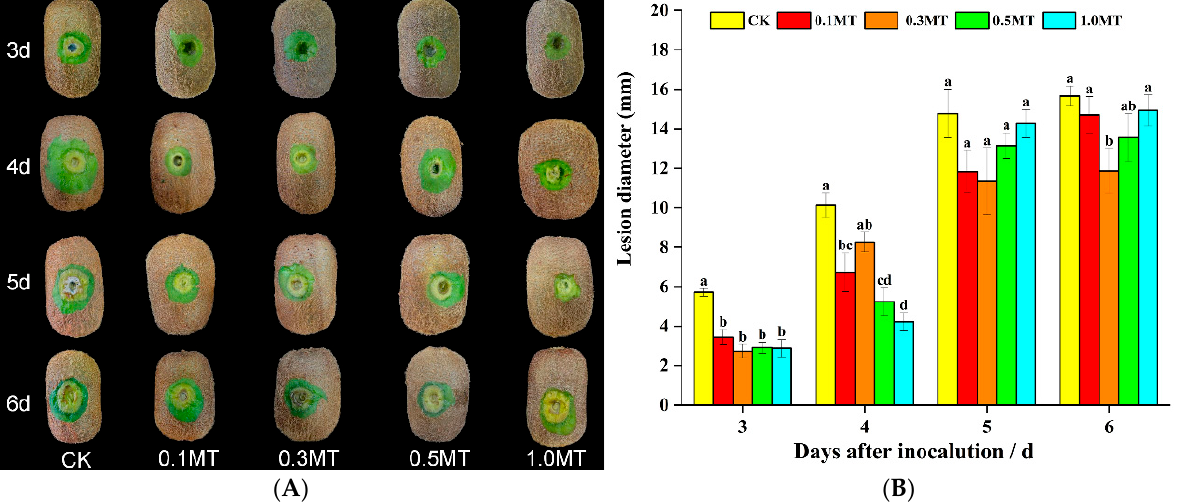
Figure 1. Effect of preharvest melatonin treatment on disease resistance of postharvest kiwifruits. ( A ) Fruit disease phenotype; ( B ) lesion diameter. Values indicate the means of the replicates; error bars indicate the standard deviations of the mean (n = 3). Different lowercase letters indicate significant differences between treatments ( p < 0.05), while identical letters indicate no significant differences between treatments ( p >